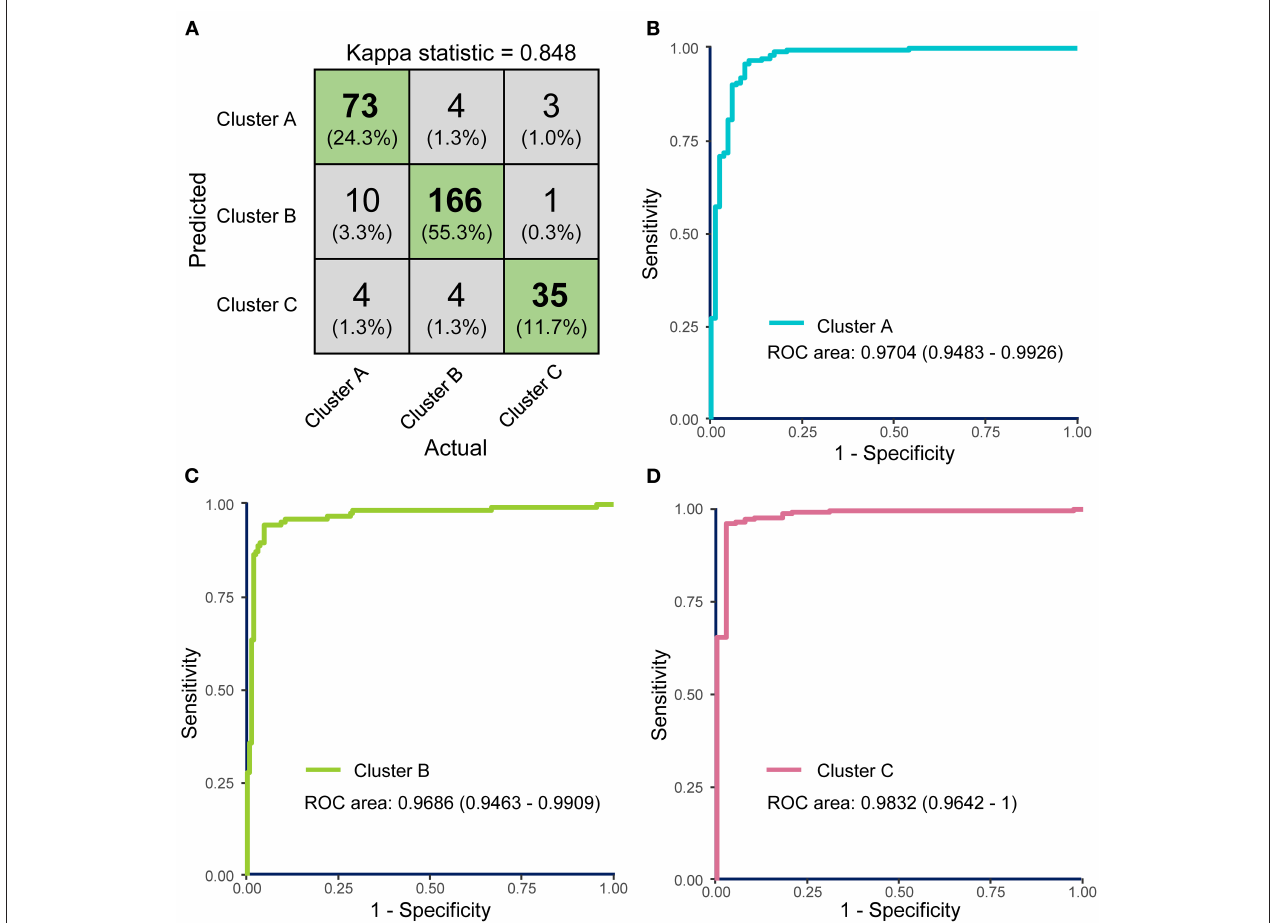
FIGURE 7 | The performance of the support vector machine (SVM)-based classifier model was evaluated by receiver operating characteristics (ROC) curves. (A) Confusion matrix showed that most COVID-19 samples in test dataset were classified precisely. (B–D) ROC curves for the SVM classifier represent the predictive powers of Clusters A, B, and C, respectively. The areas under the curves (AUCs) of the three ROC curves were 0.9926 (95% CI: 0.9872–0.9981), 0.9906 (95% CI: 0.9859–0.9960), and 0.9979 (95% CI: